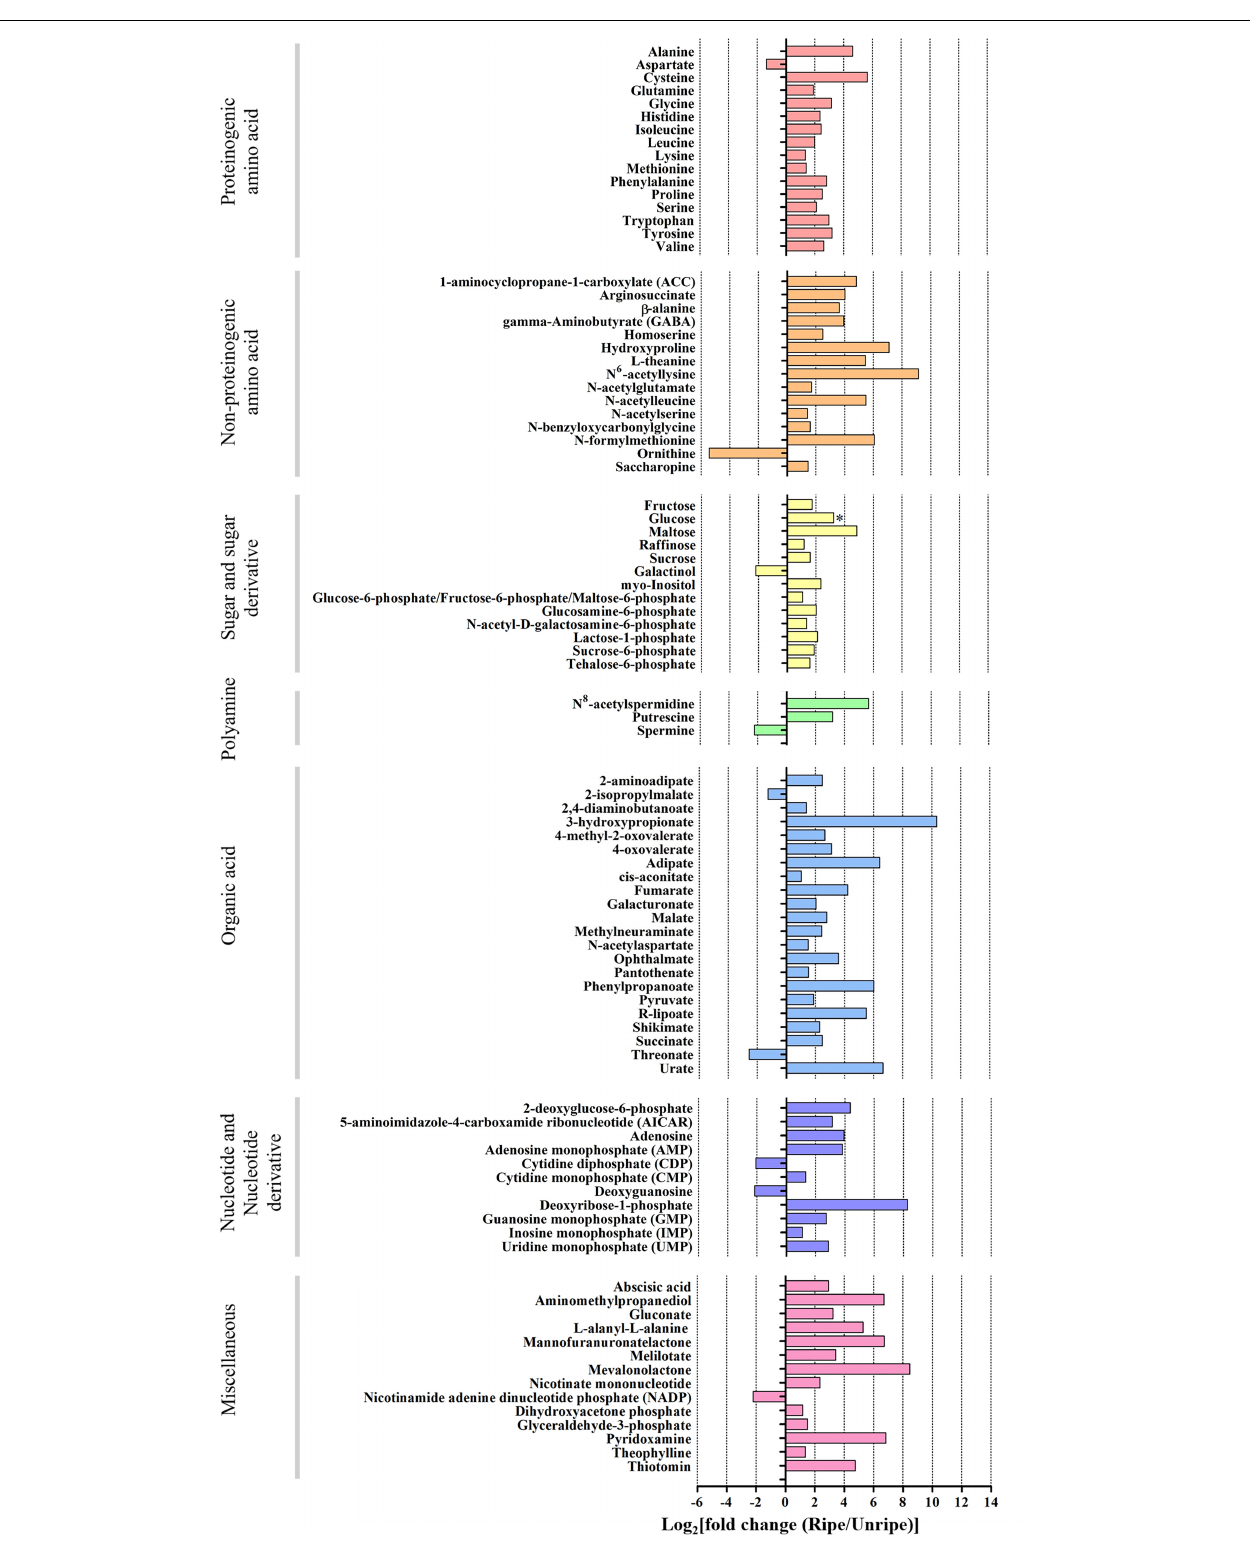
Frontiers in Plant Science |